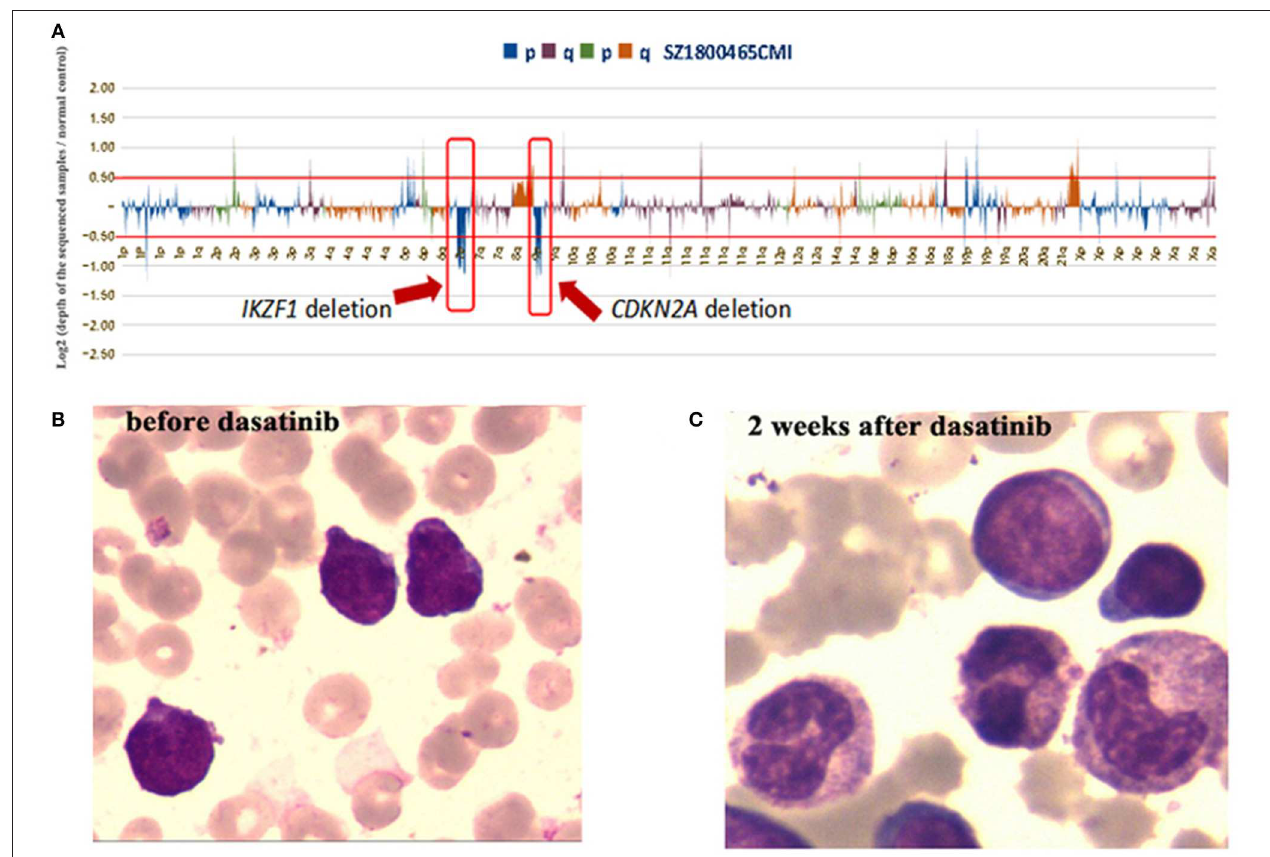
FIGURE 2 | NGS analysis of the bone marrow sample at relapse showed deletions of CDKN2A and IKZF1. (B,C) Bone marrow smears before and after dasatinib therapy. status, SH2 and SH3 bind to LYN’s phosphorylated